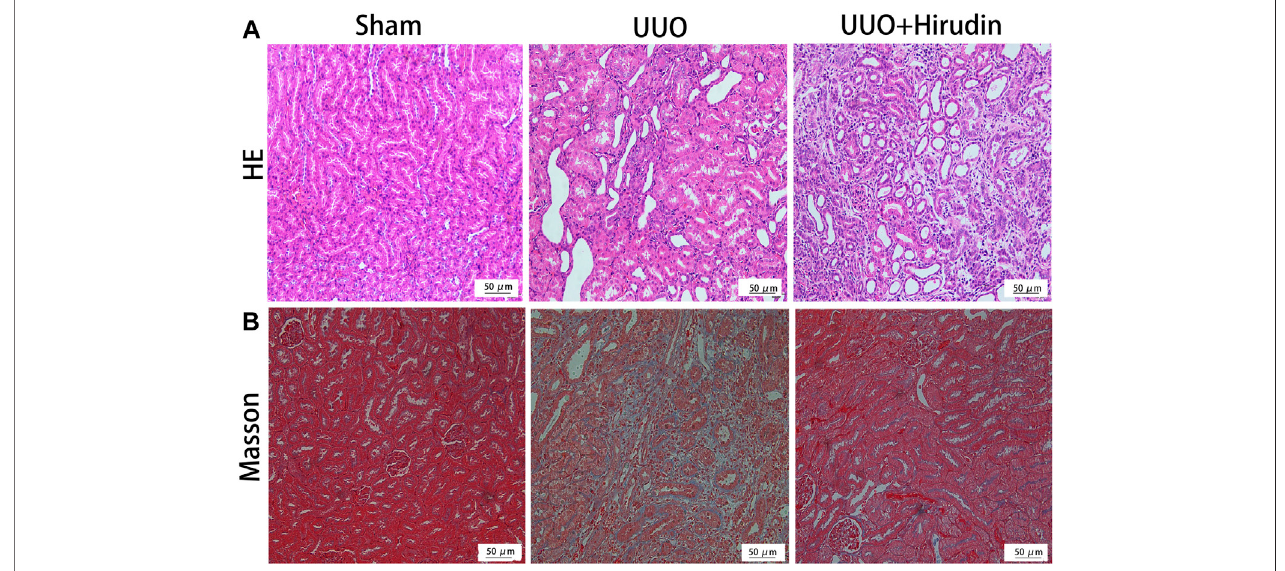
FIGURE 1 | Effect of hirudin on renal histopathological alterations in unilateral ureteral obstruction (UUO)-induced renal interstitial fi brosis (RIF) rats. (A) HE staining showedthathirudinsigni fi cantlyreducedtubulardilatationoratrophy,interstitial fi brosisandin fl ammatorycellin fi ltrationintheUUOrats(magni fi cation × 200). (B) Masson trichrome staining showed that hirudin signi fi cantly reduced renal tubulointerstitial damage and total collagen deposition in UUO rats. (magni fi cation × 400).